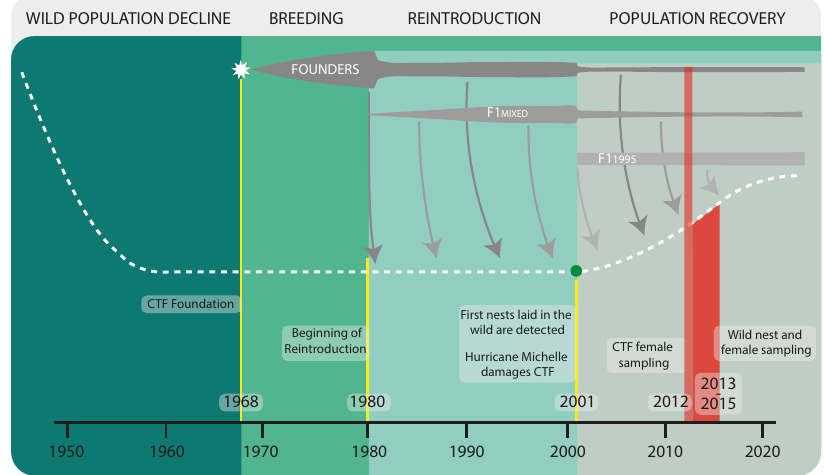
Fig. 2 Timeline of the Cayman Islands green turtle populations and the reintroduction program. The key events of the Cayman Islands green turtle populations are detailed, including their decline, the captive breeding, the reintroduction program and the recent recovery. The dashed white line represents the wild population showing the initial decline until its virtual extinction 24 and later increase 25 . The green dot on the dashed line represents the discovery of the fi rst nests laid by wild females. The grey bars at the top represent the three groups of captive breeders in the Cayman Turtle Farm (CTF): founders, F1(mixed) breeding stock and F1(1995) breeding stock. Founders were incorporated to the CTF since its beginning (white star) and suffered two major reductions, the fi rst in the 80 s following a change of farm strategy and the second due to hurricane Michelle 27 . The F1(mixed) individuals were incorporated since the 80s and also suffered the consequences of hurricane Michelle 27 while the F1(1995) individuals were incorporated to the breeding stock to replace the losses of the Hurricane. Grey arrows represent the offspring from the breeding stock released into the wild. The light red vertical bar represents the sampling of captive females for genetic analyses 26 and the red bar represents sampling of wild females 26 and the three seasons of hatchling sampling for the present study (Fig.